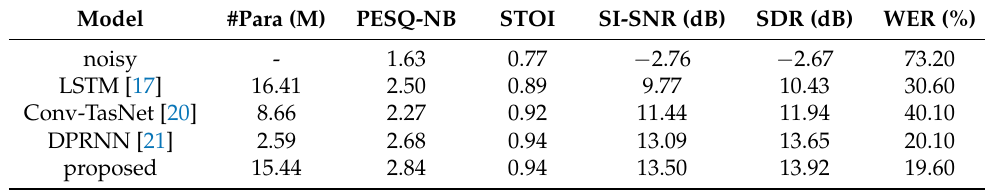
Table 5. Comparison with other methods on WHAM!.